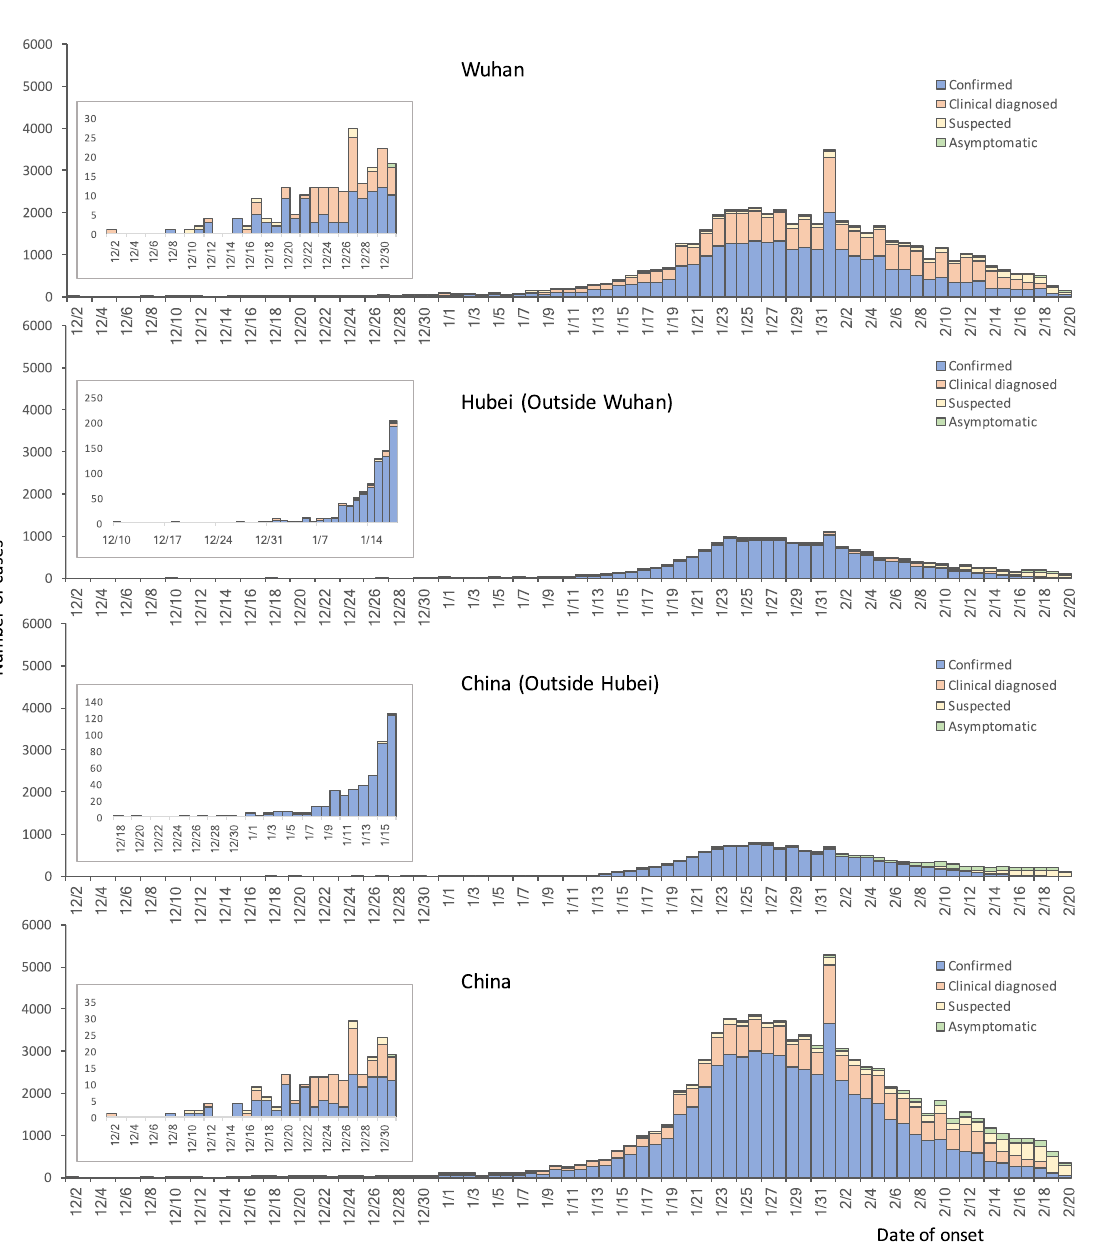
Figure 2 Epidemiologic curve of COVID-19 laboratory confirmed cases, by date of onset